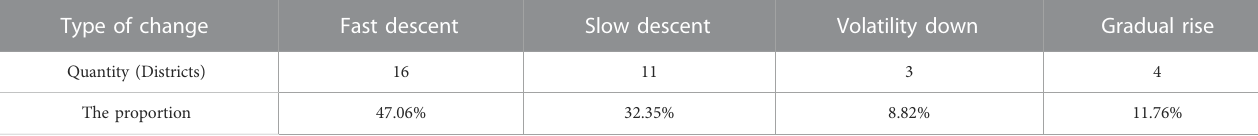
TABLE 8 Statistics on the types of changes in the level of urban resilience. Type of